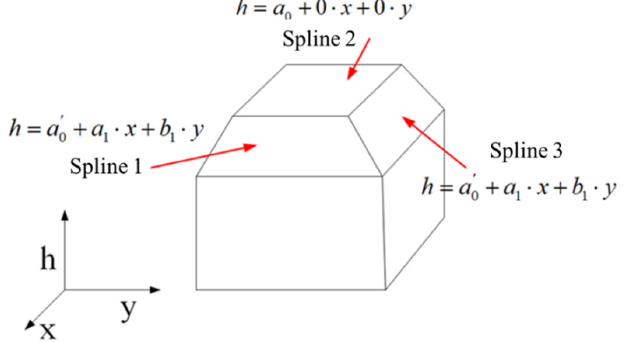
Figure 2. Four-slope-roofed building spline function description.